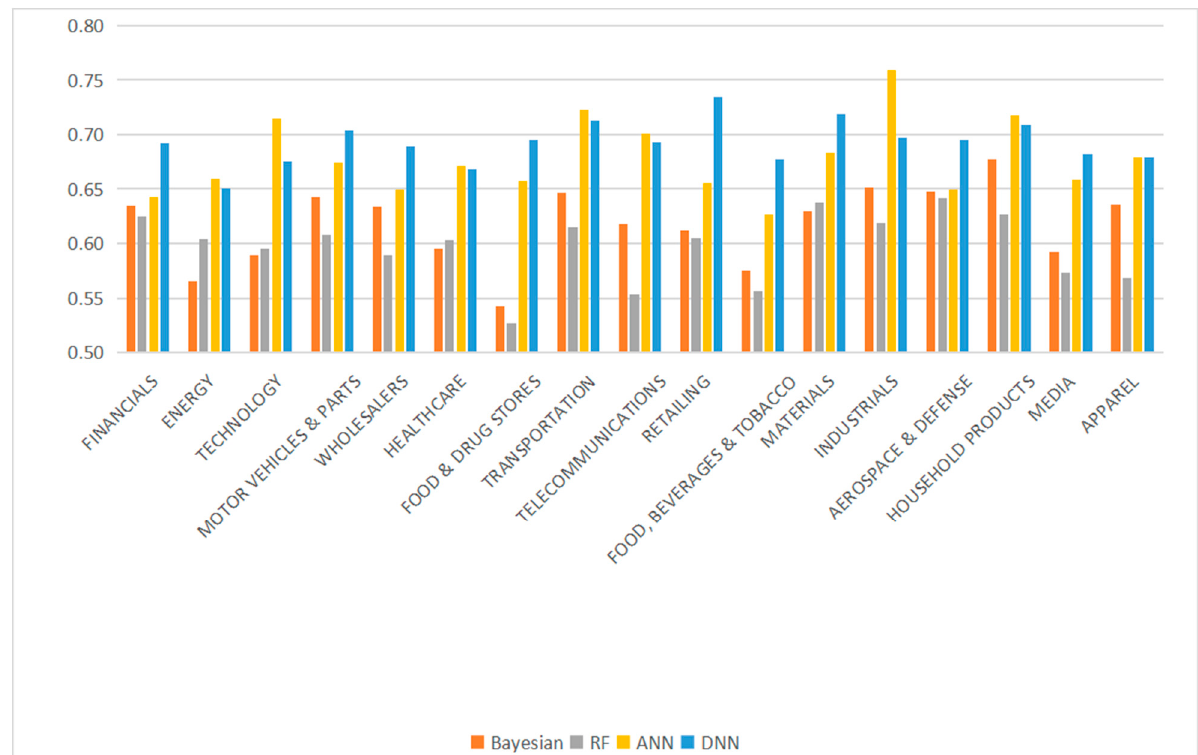
Figure 10. The evaluation of predictive accuracies in industries.